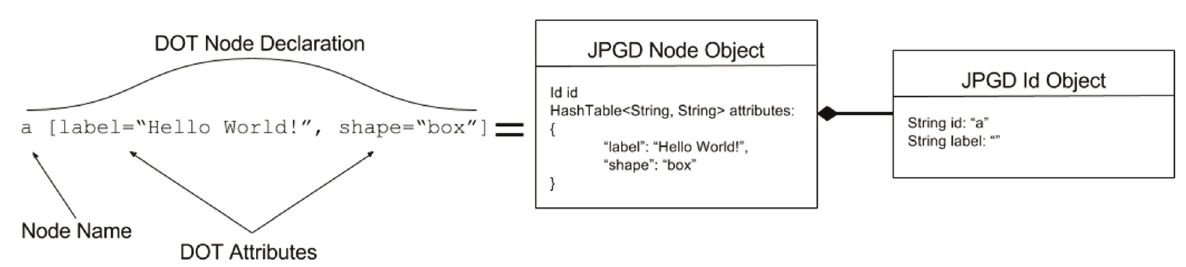
Figure 8. DOT Node Declaration to JPGD Node Object.